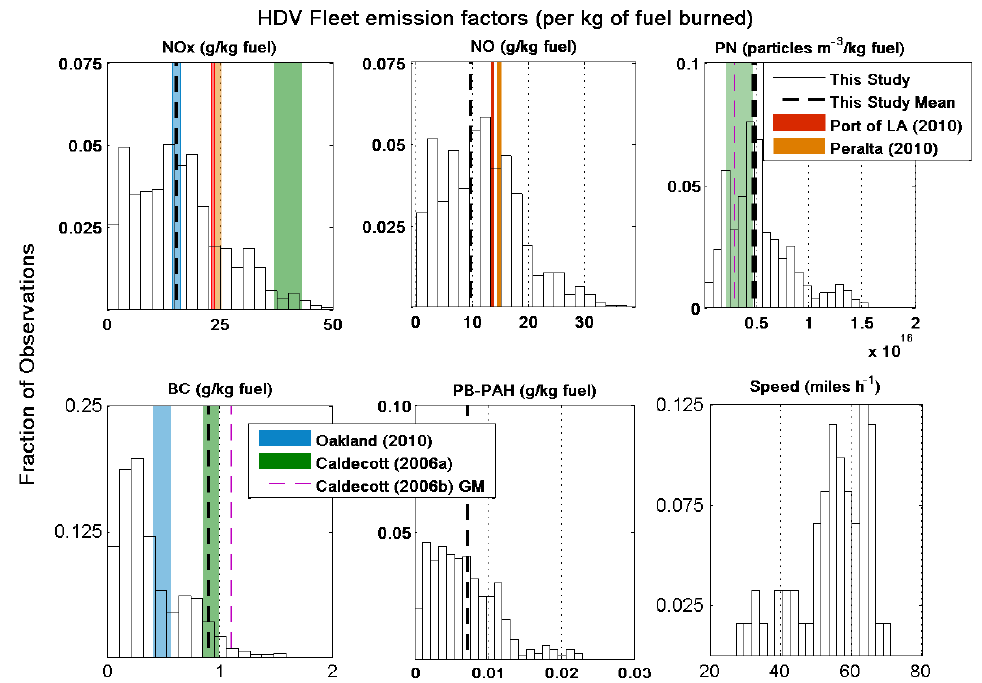
Fig. 2. HDD emission factors. Oalkand (2010) results represent individual vehicle plume averages reported by Dallmann et al. (2011), Caldecott (2006a) refers to Ban-Weiss et al. (2009) results, Caldecott (2006b) refers to Ban-Weiss et al. (2010) geometric means based on individual vehicles, and PoLA (2010) and Peralta (2010) refer to Bishop et al. (2012) results. Colored bars span the reported one standard deviation range. BC x-axis was truncated for clarity, values extend upto 15gkg-fuel − 1 . Also note the exponent on the x-axis for PN EFs.